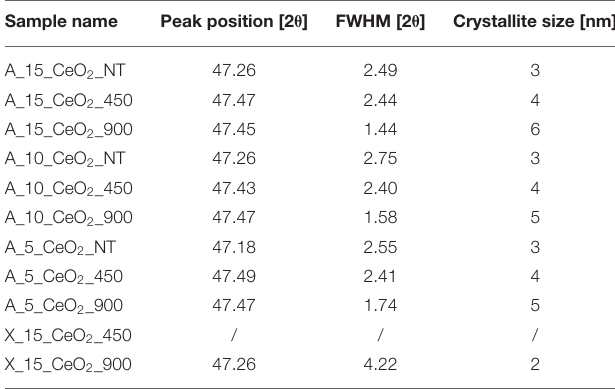
TABLE 1 | Peak position, FWHM (corrected for an instrumental broadening of 0.18 ◦ ) and average crystal sizes calculated from the XRD patterns using the Scherrer